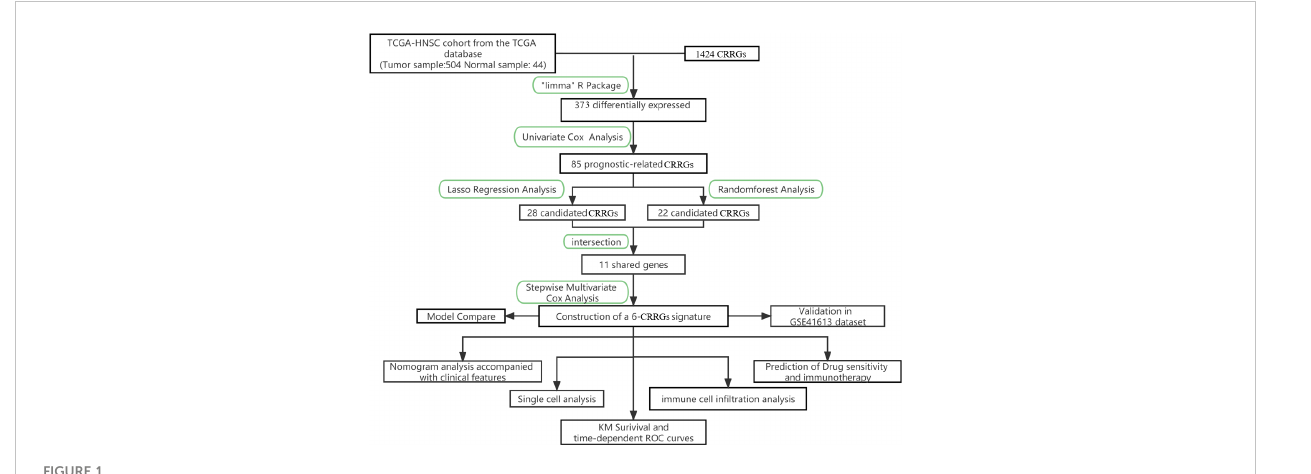
FIGURE 1 The fl owchart summarizes the main design of the present